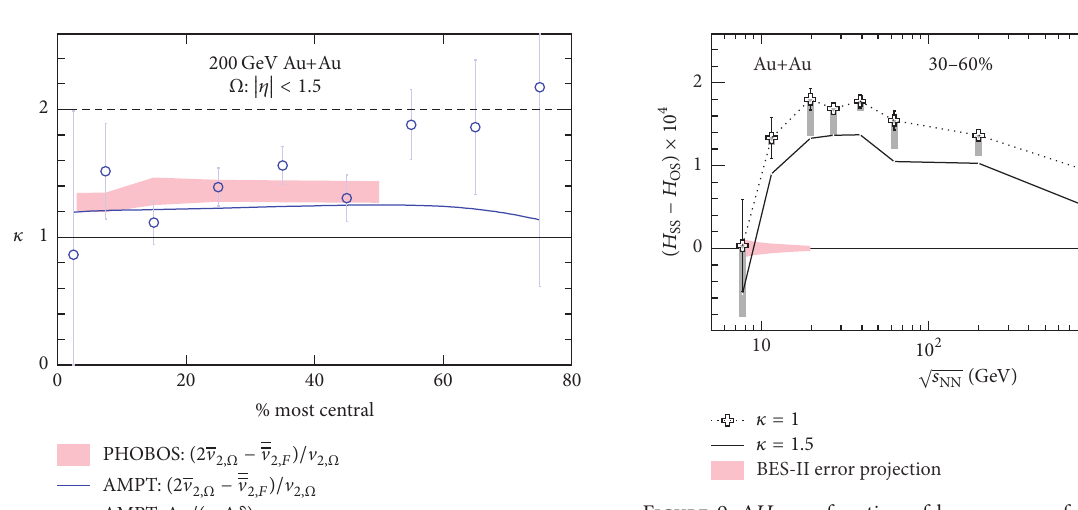
Figure 9: Δ𝐻 as a function of beam energy for 30–60% Au+Au (Pb+Pb) collisions [48, 49]. The systematic errors (gray bars) bear the same meaning as in Figure